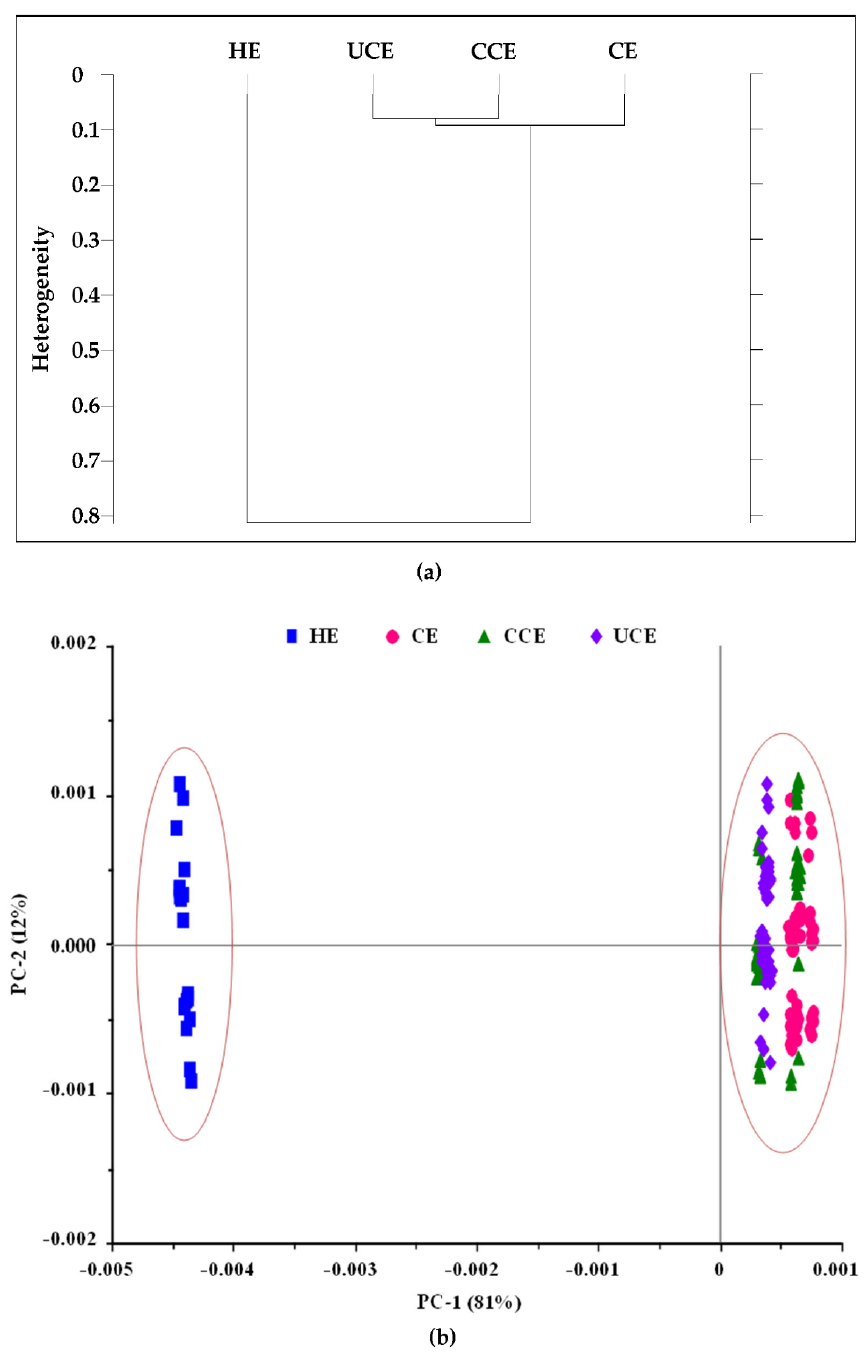
Figure 7. ( a ) Two-dimensional HCA dendrograms of CRBO from different extraction processes; ( b ) two-dimensional PCA score plot showing the first and second principal components (PC-1 and PC-2) for the SR-FTIR spectra.